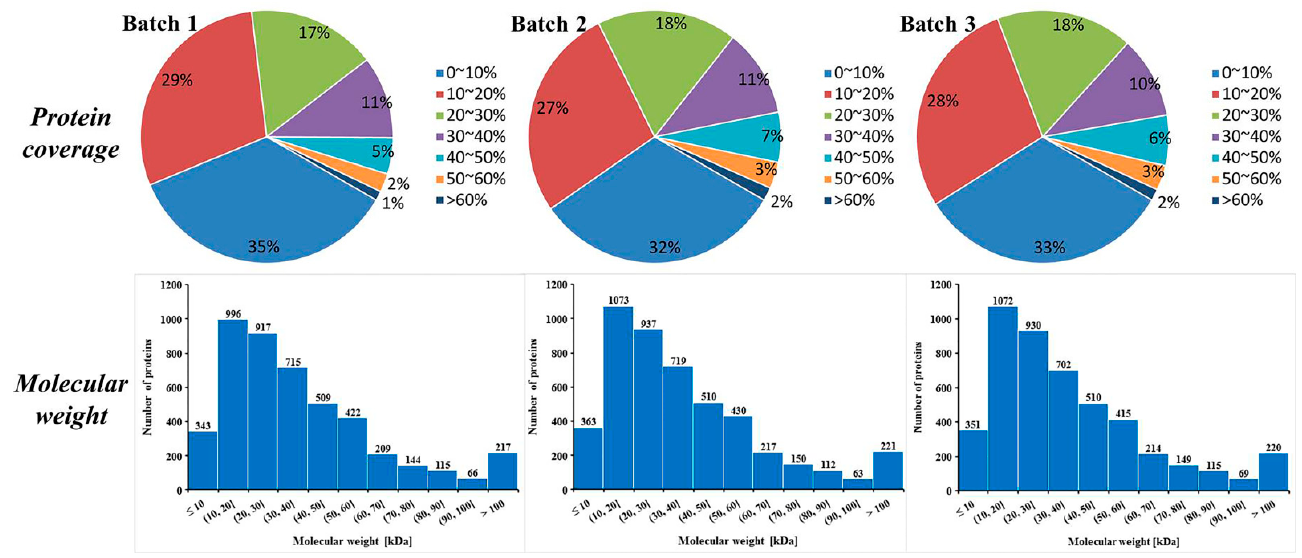
Figure 2. Coverage of proteins by the identified peptides and distribution of the identified proteins among the different molecular weight classes (in kD).